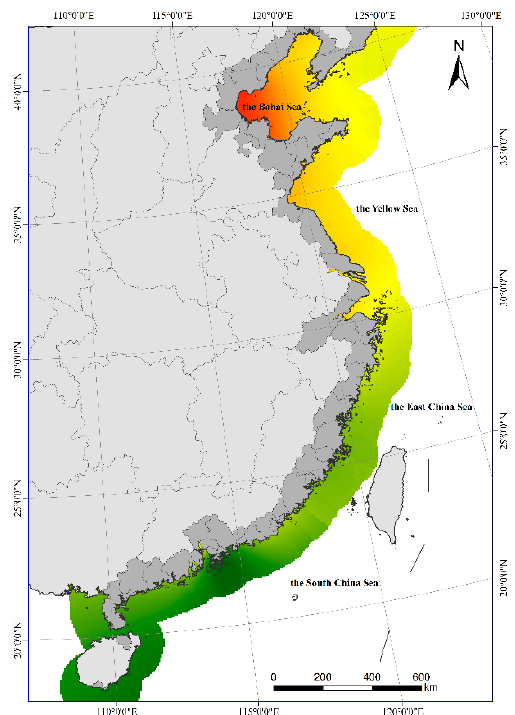
Figure 9. The heat map of the air quality index (AQI) in the coastal area of China in 2014.